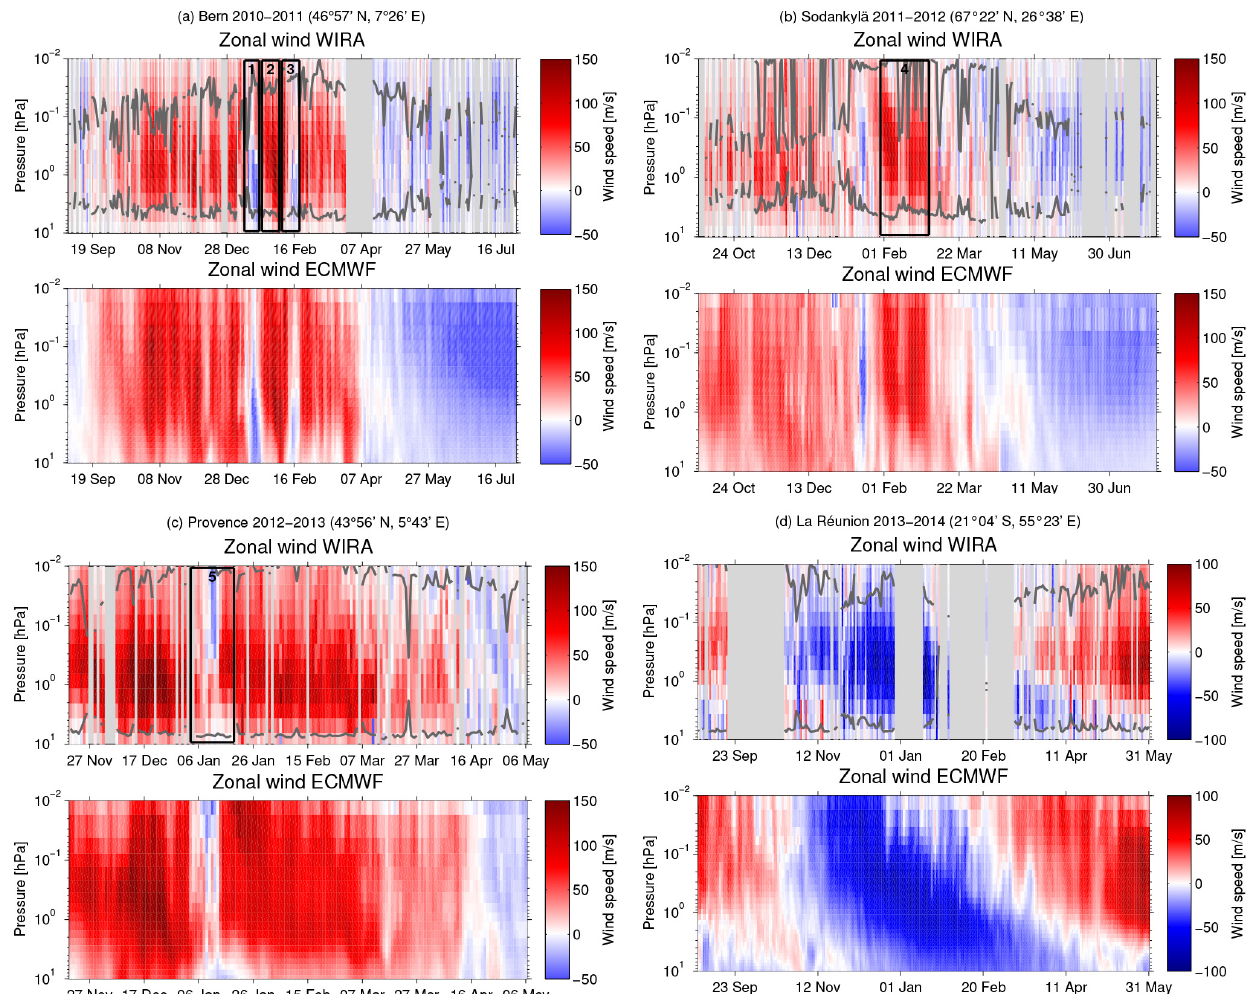
Figure 14. Zonal wind time series measured by WIRA at four different locations compared to ECMWF operational analysis data. The grey lines delimit the trustable altitude range of the retrieved data. The black rectangles mark the dynamic episodes described in the